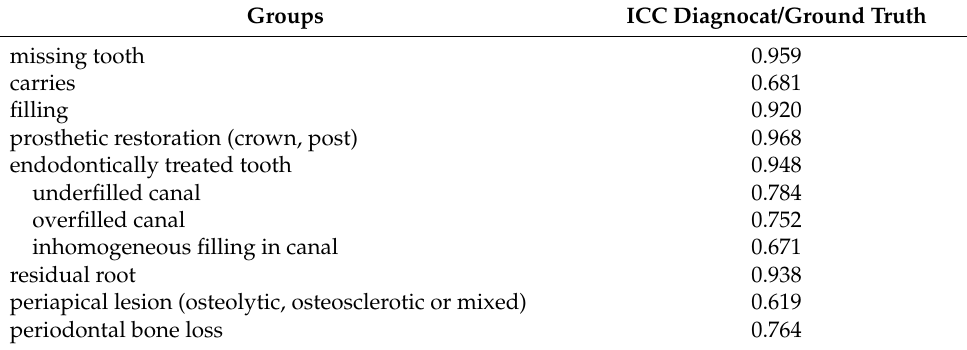
Table 3. ICC over ground truth for different evaluated